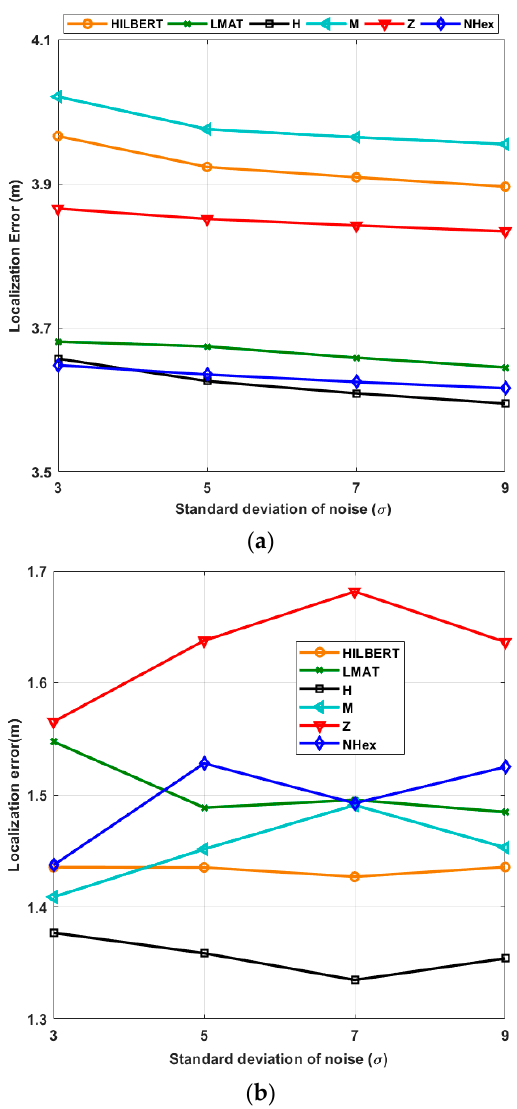
Figure 13. Average localization errors of the models according to the std of the noise ( R = 1) in ( a ) WCL, and ( b ) APT. WCL, and ( b )